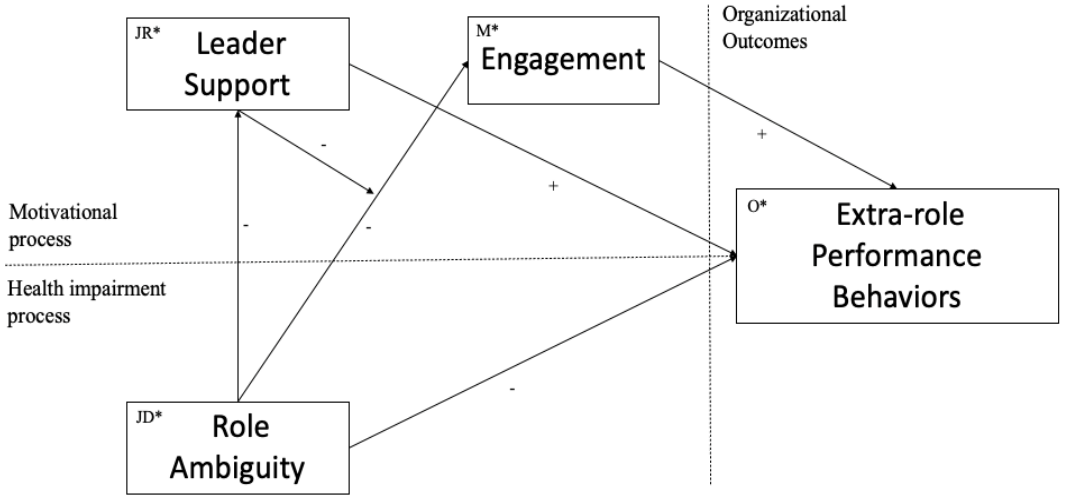
Figure 1. Research model. JD* = job demands; JR* = job resources; M* = motivation; O* = outcomes.